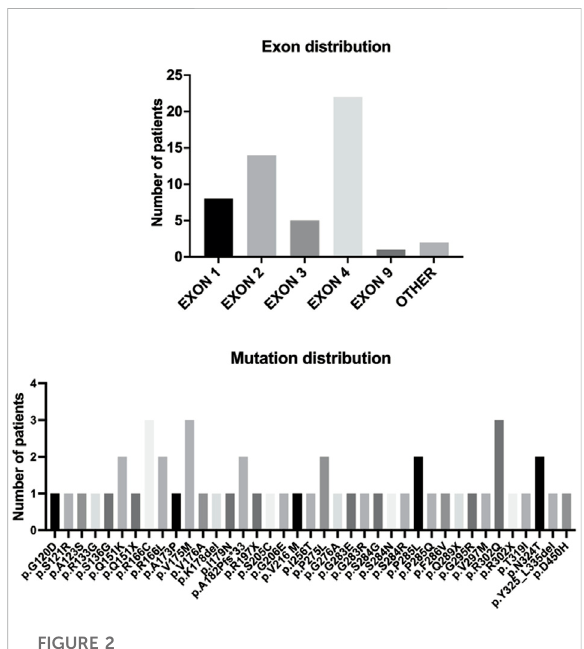
FIGURE 2 The HTRA1 mutations identi fi ed in patients with HTRA1 - associated dominant cerebral small vessel disease. The bar chart above represents the exon distribution of identi fi ed heterozygous HTRA1 mutations. The bar chart below represents the identi fi ed heterozygous HTRA1 mutations so